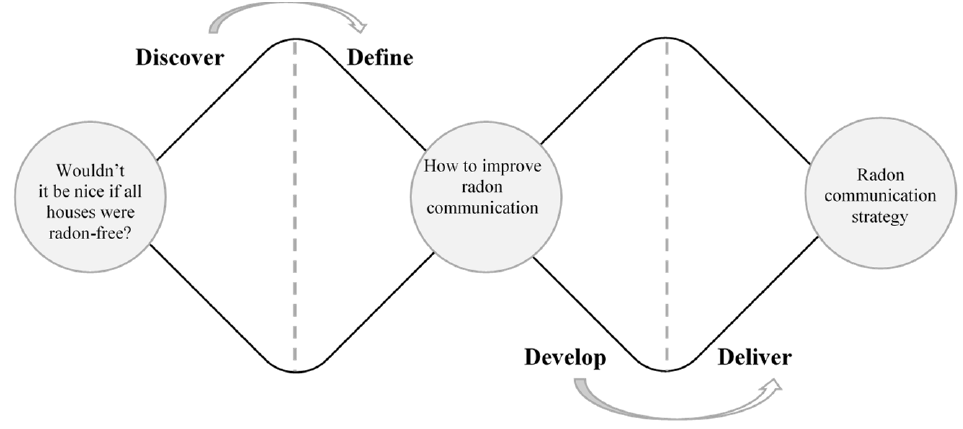
Figure 1. The double diamond framework applied to radon.